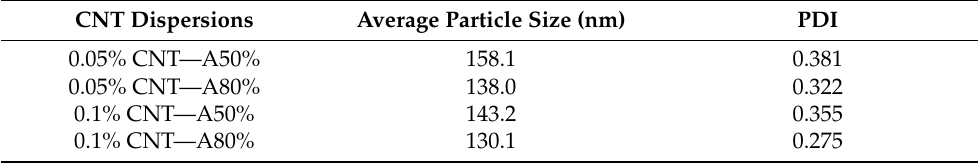
Figure 4. Influence of ultrasonication amplitude on particle size distribution of ( a ) 0.05% CNT and ( b ) 0.1% CNT dispersions.